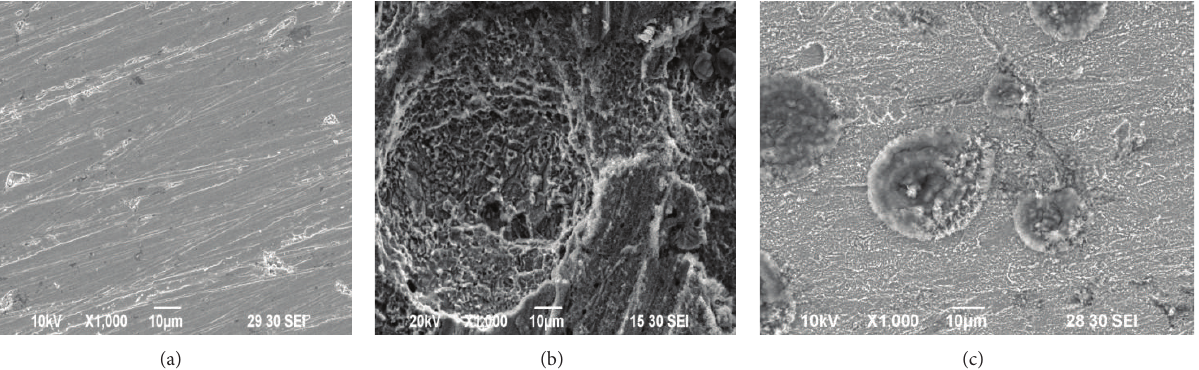
Figure 16: SEM photographs of mild steel sample (a) polished surface, (b) after immersion in 1N H 2 SO 4 solution, and (c) in the presence of (2 × 10 −3 M) inhibitor